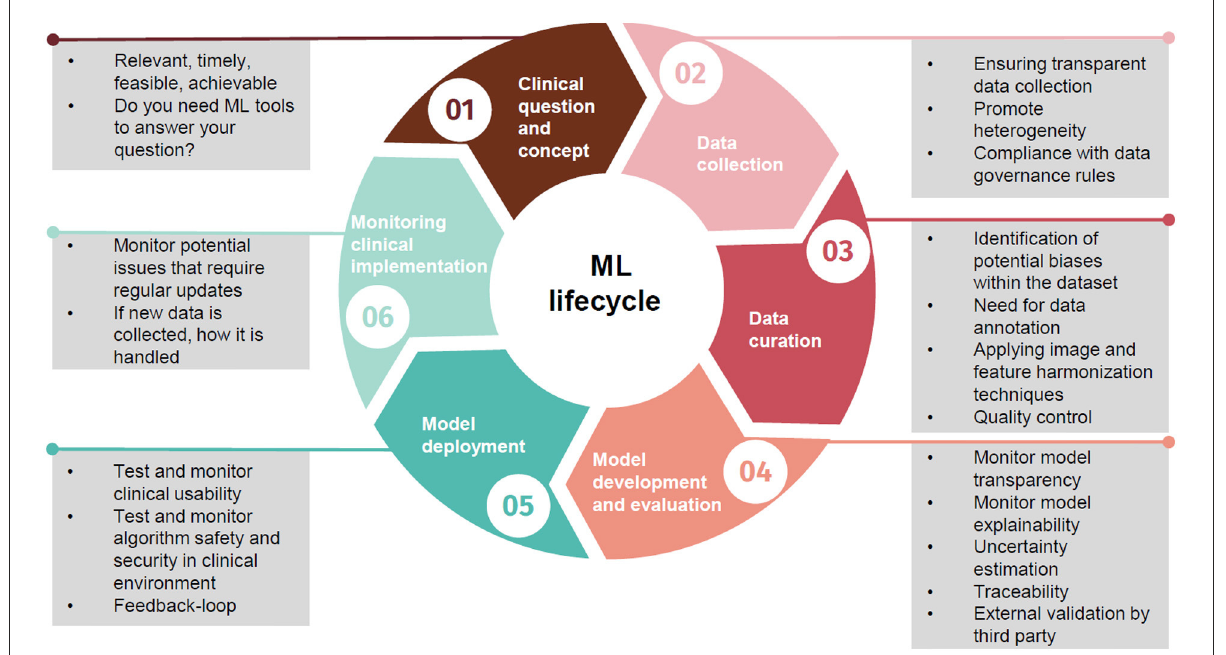
FIGURE1 Principles of trustworthy AI within the machine learning